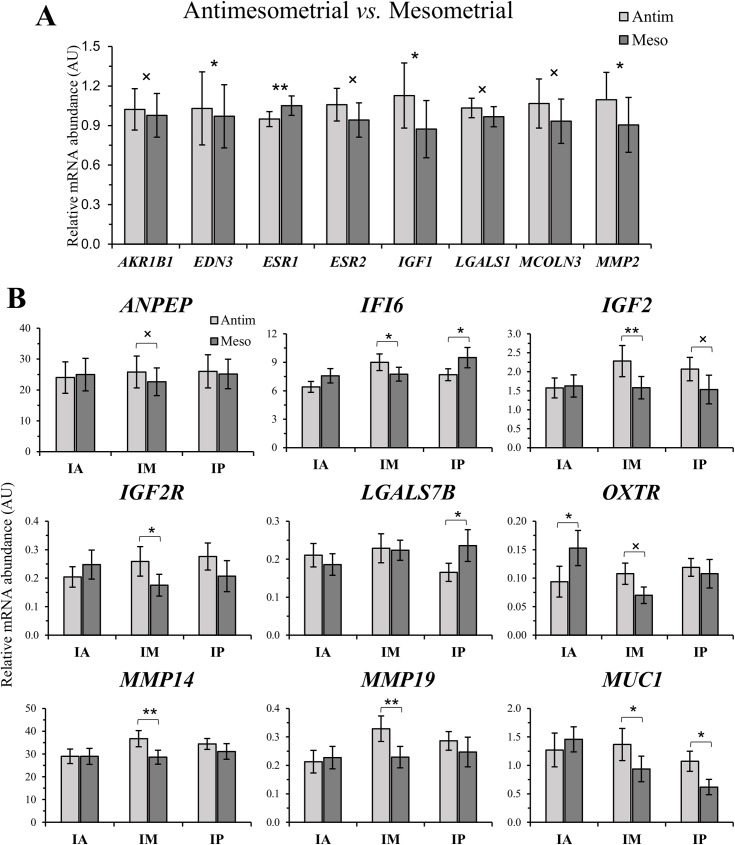
Relative mRNA abundance of genes affected by Side (antimesometrial vs. mesometrial; Panel A; arbitrary units: AU; mean ± SEM) and by the Side by Region (IA, IM vs. IP; Panel B; arbitrary units: AU; mean ± SEM) interaction in the uterine horn ipsilateral to the CL. *P < 0.05 and ˟P < 0.1 denotes that significant differences were reached or approached, respectively, between sides at each specific region.